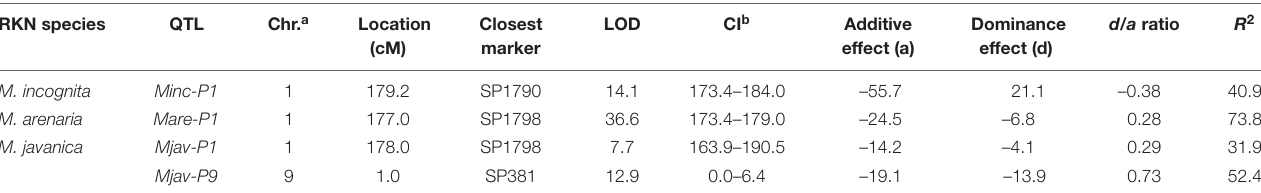
TABLE 2 | Quantitative trait loci (QTLs) for resistance to the different RKN species in the pepper F 2 : 3 progeny. RKN species